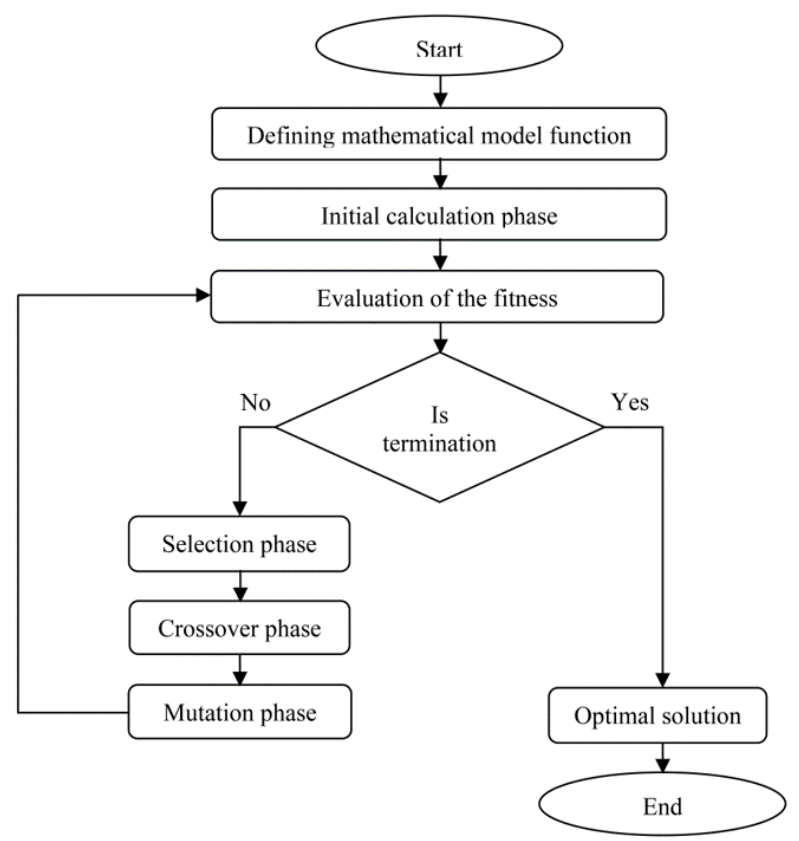
Figure 5. Flowchart of Genetic Algorithm (GA).